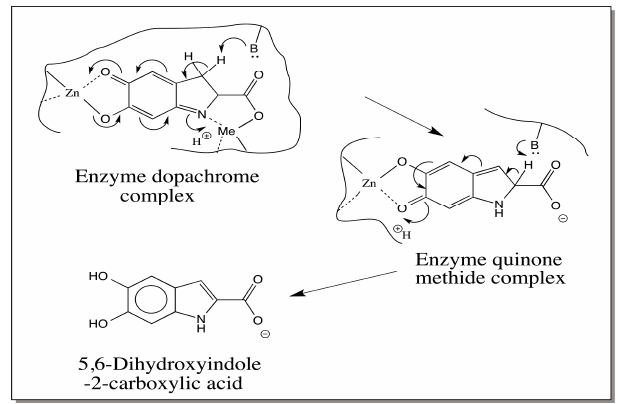
Figure 4. One possible mechanism for dopachrome conversion to DHICA by mammalian dopachrome tautomerase (DCT). Mammalian DCT possesses two metal binding sites. If one metal ion binding site is occupied by the quinonoid nucleus and the other by the amino group and carboxyl group, the isomerization to